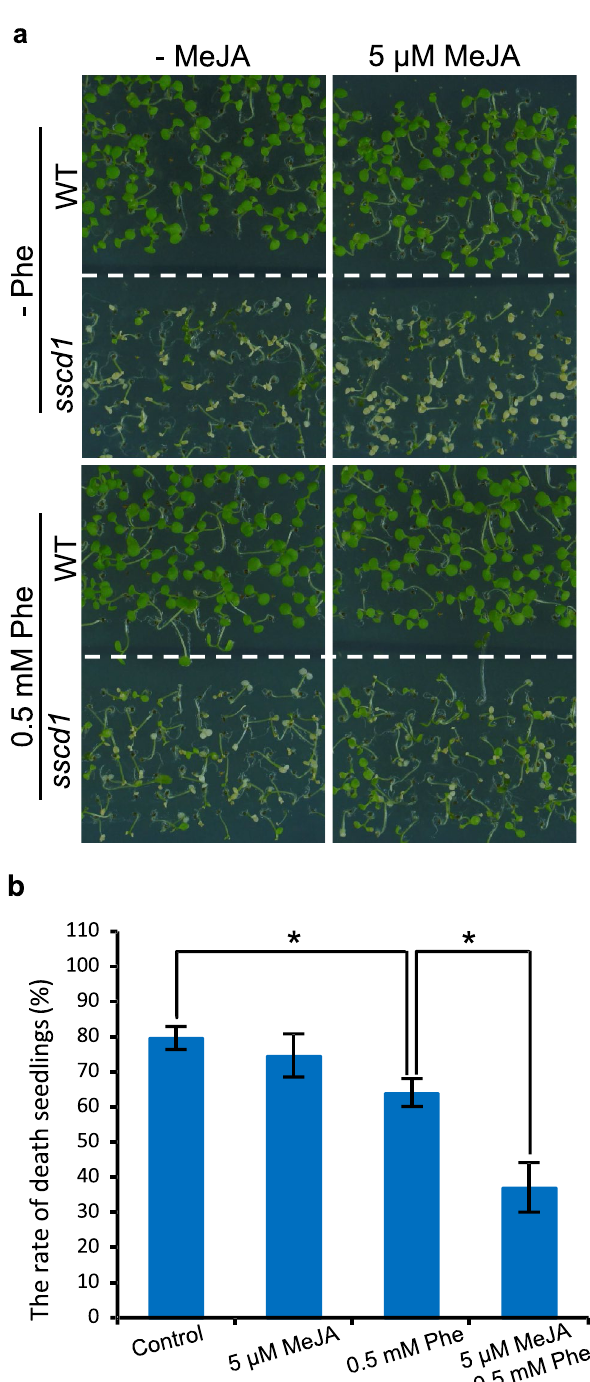
Figure 5. Treatment with MeJA enhanced the inhibitory effect of Phe on the sscd1 seedlings death. ( a ) The phenotype of WT and sscd1 seedlings which were grown in medium added without (−) or with 0.5 mM Phe or/and 5 μM MeJA under SD for 7 days. ( b ) The death rate of sscd1 seedlings which were grown in medium added without (control) or with 5 μM MeJA or/and 0.5 mM Phe under SD for 7 days. Error bars represent standard deviations (n > 30). The experiment was performed in three independent biological repeats. An asterisk represents the significance of differences (two-tailed Student’s t-test) at the level of P < 0.05. WT wild type, Col-0; Phe phenylalanine; MeJA methyl jasmonate; SD short